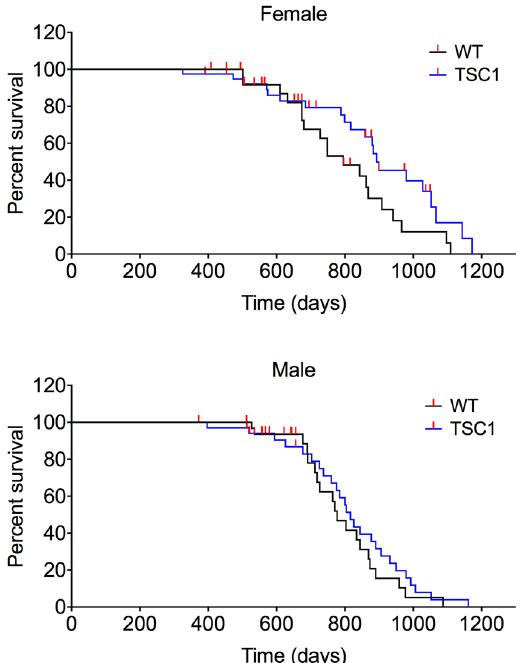
Figure 9. Lifespan analysis of TSC1 tg mice. Survival curves are shown for female and male mice separately (67 females: 27 and 40 for wild type and TSC1 tg mice separately; 67 males: 32 and 35 for wild type and TSC1 tg mice respectively). The survival curve for female mice is significant, while not for male mice (p = 0.0282 for female mice; p = 0.195 for male mice, determined by one sided Log-rank test